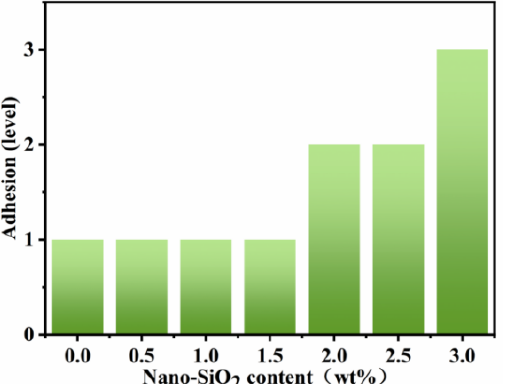
Figure 6. Effect of nano-SiO 2 content on adhesion of WAA paint film.